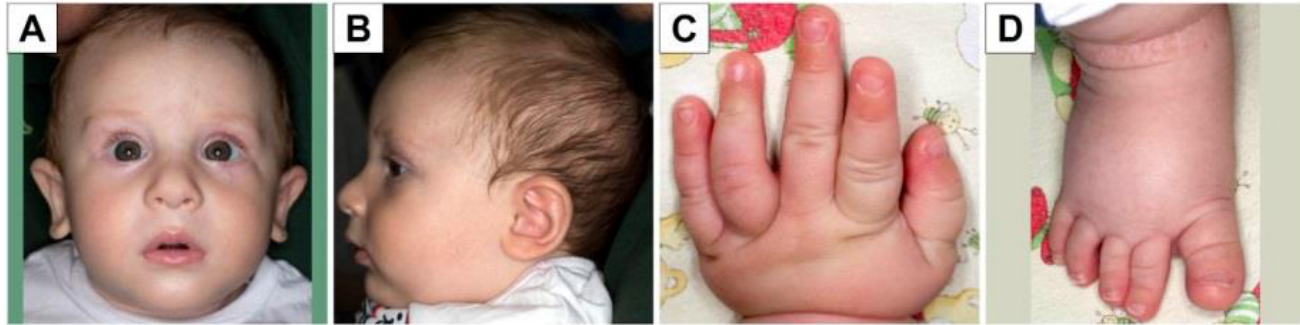
Figure 1. Phenotypic characteristics of the patient. Note bitemporal narrowing ( A ), slightly protruding ears ( A , B ) with up-lifted lobes ( A ), posterior plagiocephaly ( B ). Normal hands and nails ( C , D ) except for large first toe ( D ).